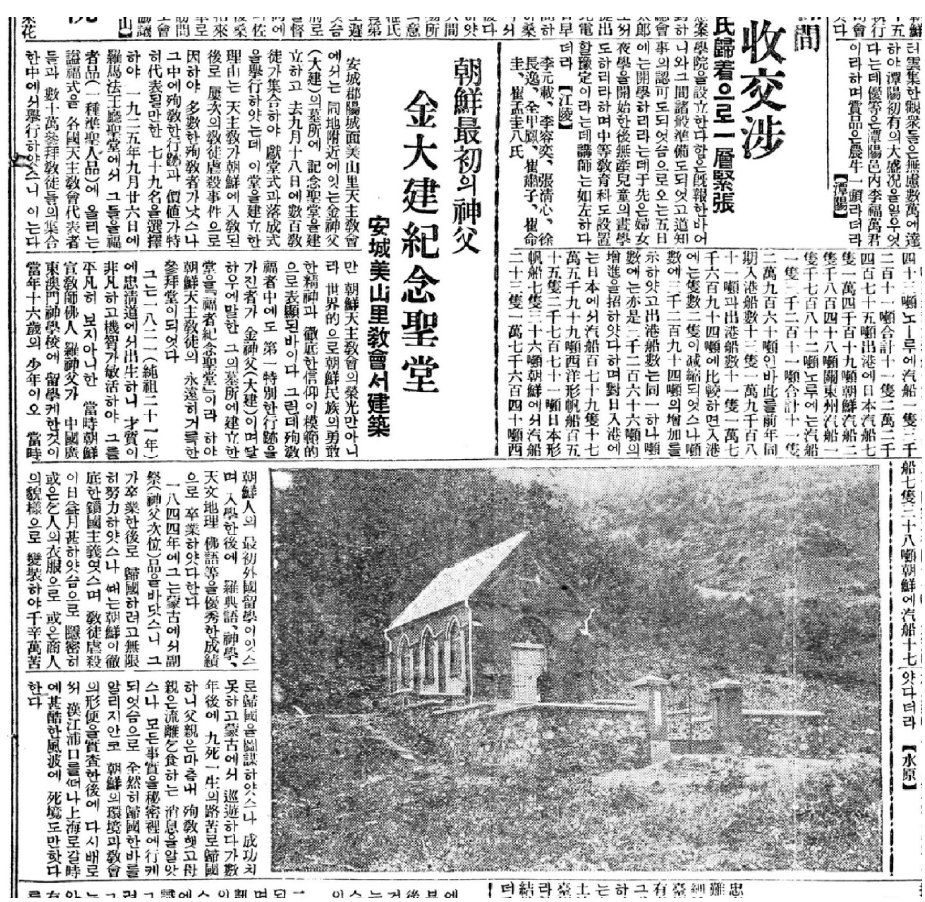
Figure 2. Article on the newly built St. Andrew Kim Dae-Geon Memorial Church [source: The Dong-A Ilbo , 5 October 1928].